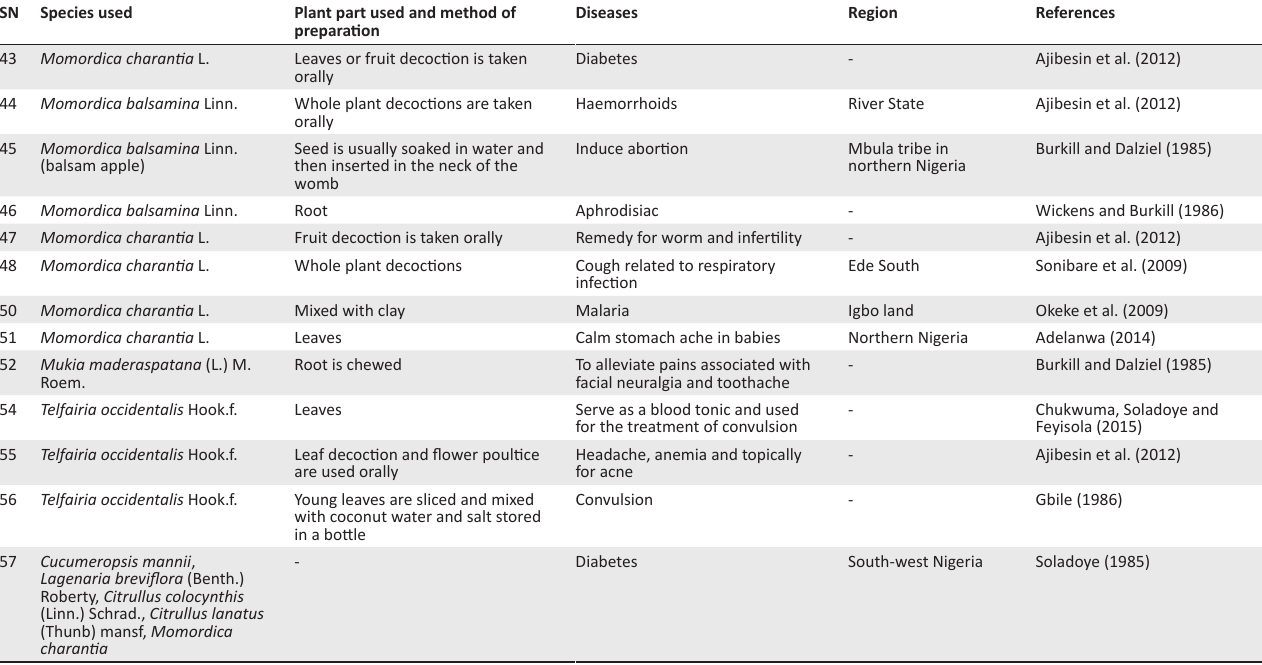
TABLE 1 (Continues...): Cucurbitaceae species used as traditional medicine in Nigeria. SN Species used